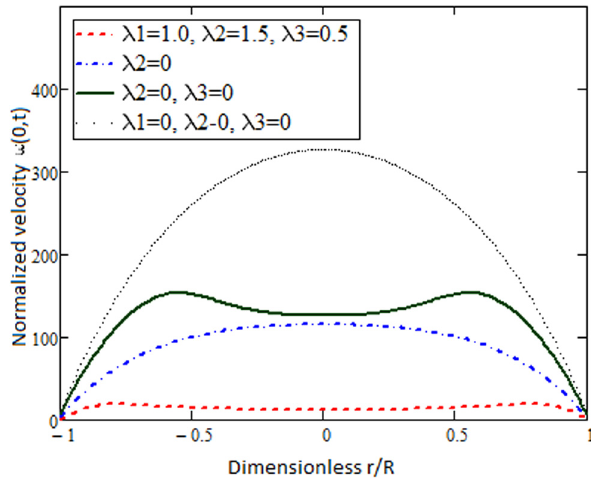
Figure 6: Comparative behavior of Oldroyd - B, Maxwell, Newtonian, and Burgers ’ fl